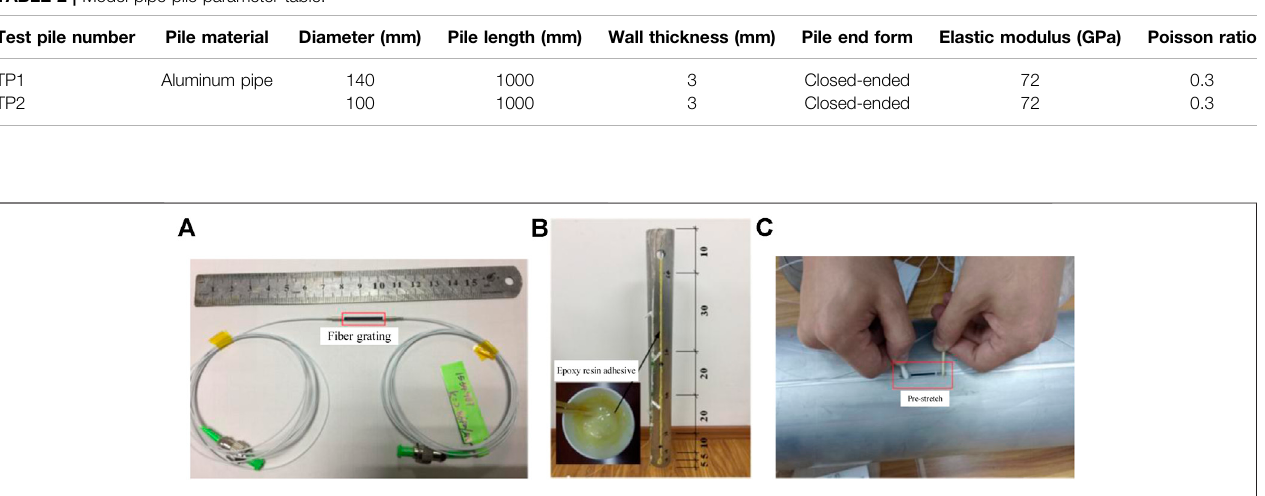
TABLE 2 | Model pipe pile parameter table.